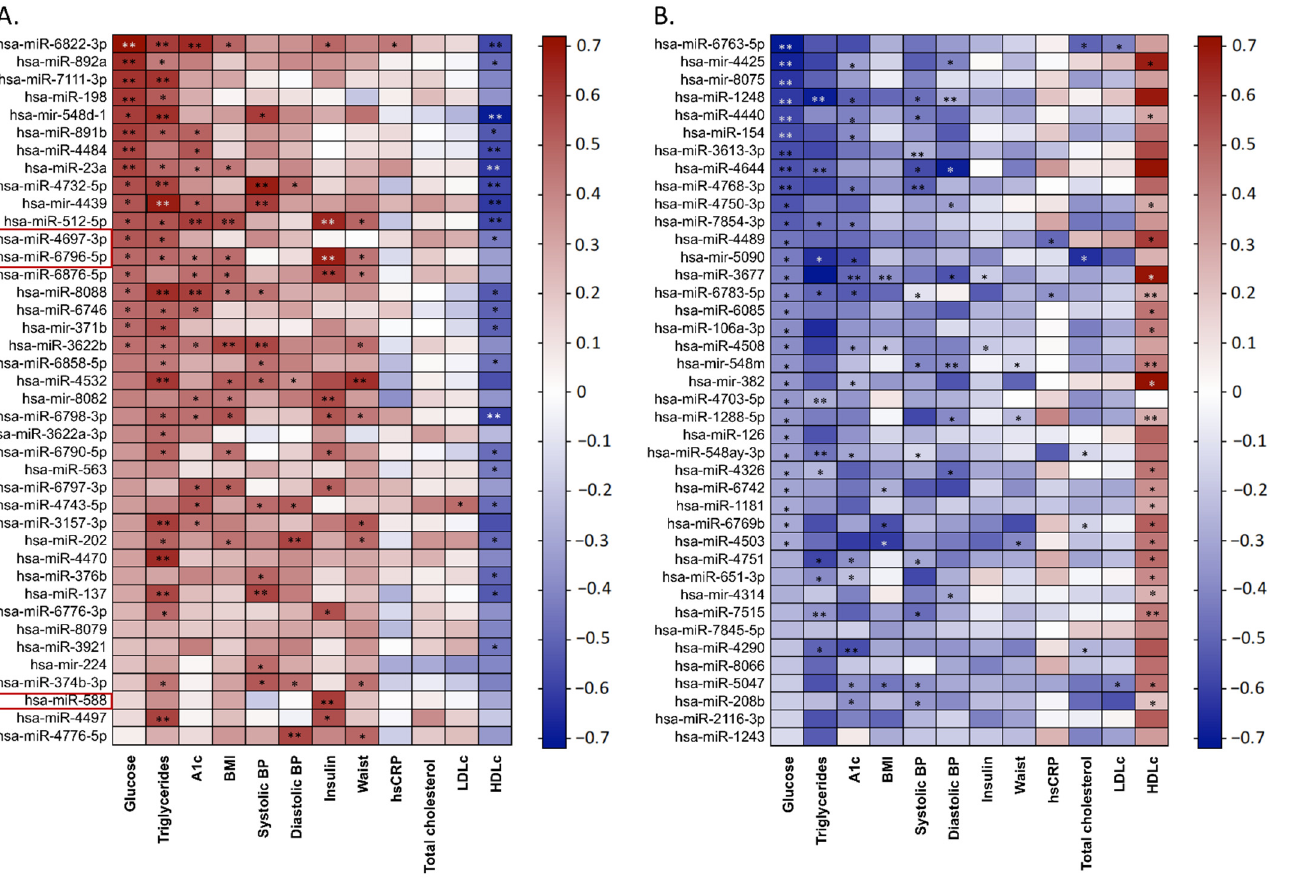
Figure 6. Correlations between top 40 upregulated ( A ) and downregulated ( B ) miRNAs and anthropometric and biochemical parameters in the MUO group. * p < 0.05; ** p < 0.01. Colour keyrepresents Spearman rank correlation coefficients in a colour gradient (red: positive and blue negative values).